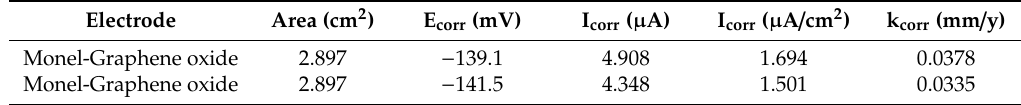
Table 4. Tafel plot analysis Monel coated with graphene